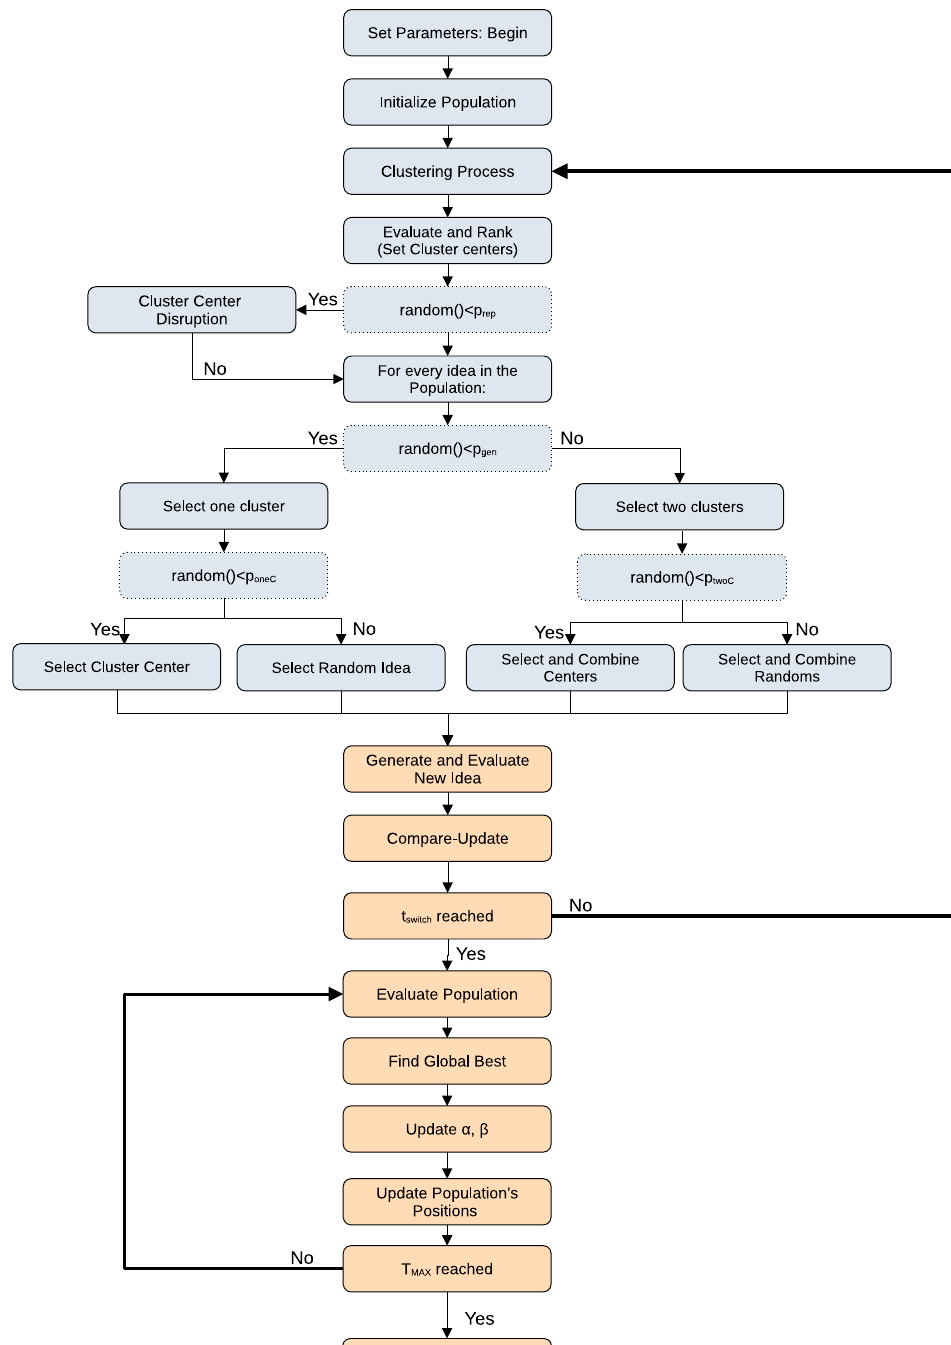
Figure 1. Flowchart diagram of the BSO–CAPSO hybrid